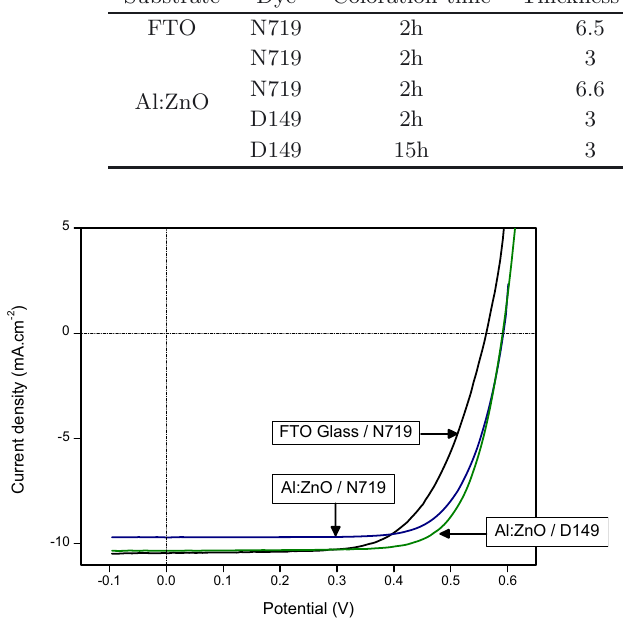
Fig. 6. Current density – voltage characteristics of dye- sensitized solar cells based on nanoporous ZnO grown on FTO glass and dyed with N719 for 2 h, on ZnO:Al and dyed with N719 for 2 h and grown on ZnO:Al and dyed with D149 for 15